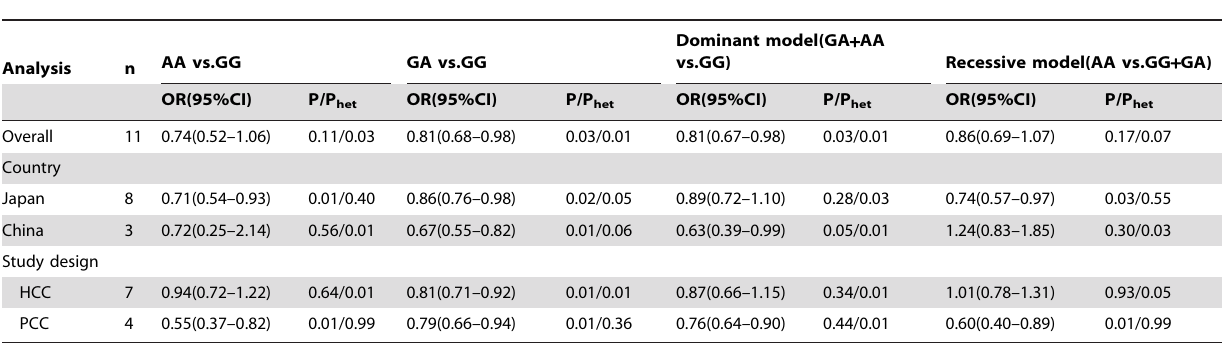
Table 2. Summary ORs and 95% CIs of ALDH2 Glu487Lys polymorphism and colorectal cancer